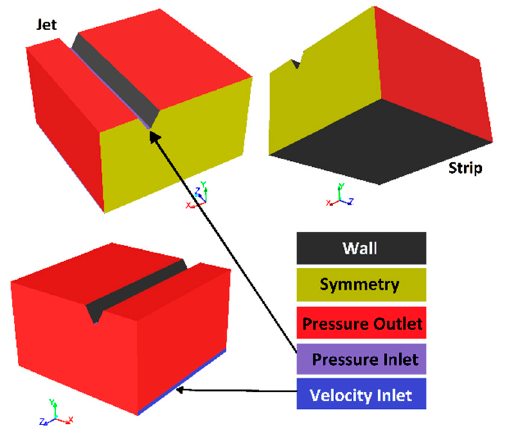
Figure 2. Geometry and boundary